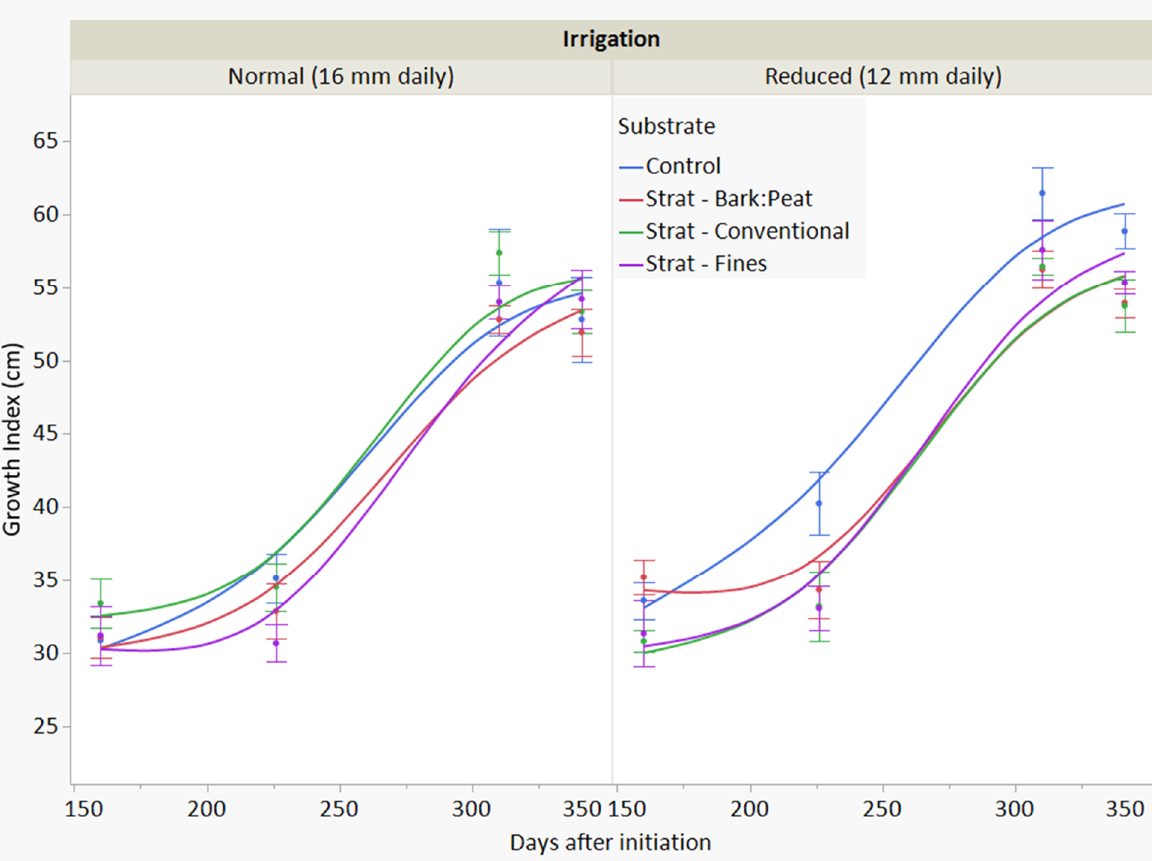
Figure 5. The change in growth index during the spring flush for Drift roses planted in a conventional pine bark substrate (control) or stratified substrates, in which either conventional pine bark substrate amended with 35% peat (by vol.; bark– peat), conventional pine bark (conventional), or fine pine bark (fines) was layered on top of coarse screened pine bark. Plants were irrigated with 16 mm (normal; control) or 12 mm of water daily (reduced). Measures reported from 160 to 340 days after initiation. Bars represent standard errors from the mean.